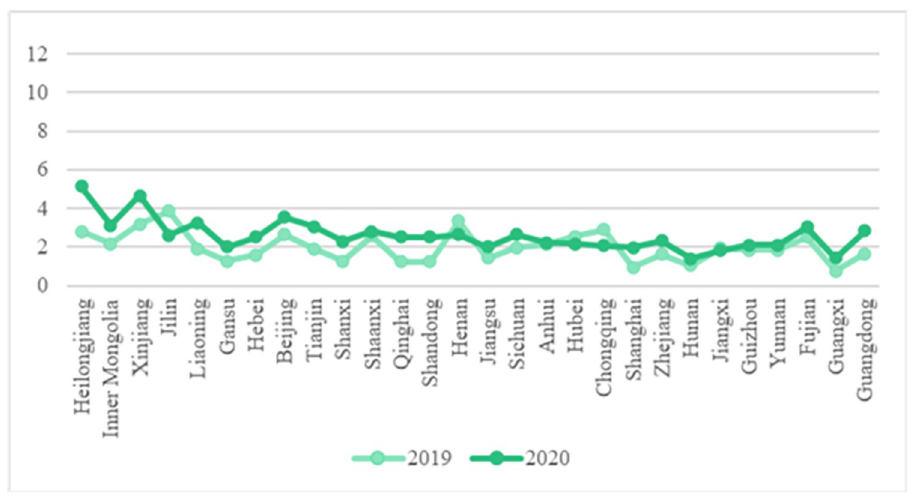
Fig 7. Broken line chart of cabbage price comparison across the country.